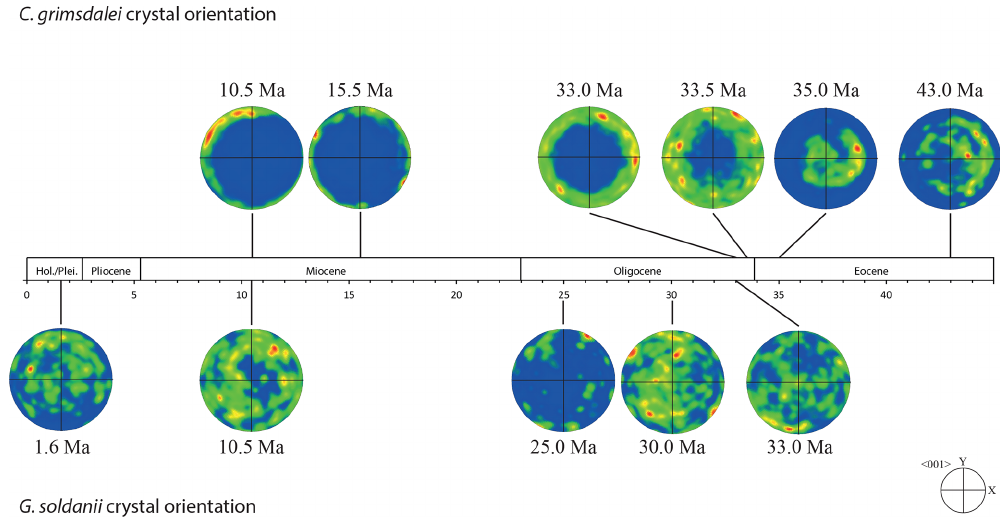
Figure 6. Crystal orientation ( c -axis pole plots (cid:104) 001 (cid:105) ) of Cibicidoides grimsdalei and Gyroidinoides soldanii tests as a function of age.